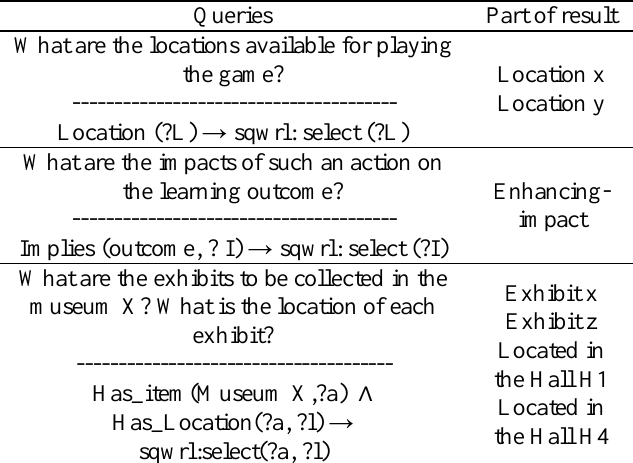
Table 4. Informal and formal questions to the requirements ontology Queries Part of